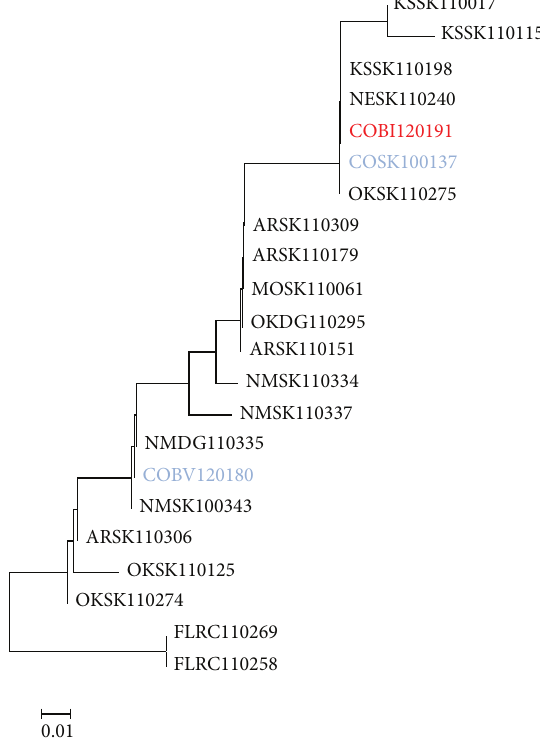
Figure 2: A phylogenetic tree of rabies virus sequences generated from specimens infected with south central skunk variant. A neighbor joining analysis was performed on nucleoprotein gene sequences. Sequences from two raccoon virus variant samples were included as an out group. Samples are identified by their state of origin, animal species, and year of isolation (KSSK11 indicates a skunk from Kansas in 2011). The viral isolate recovered from the second bison in this account is shown in red, while 2 other isolates from Colorado appear in blue. A distance scale is shown at bottom